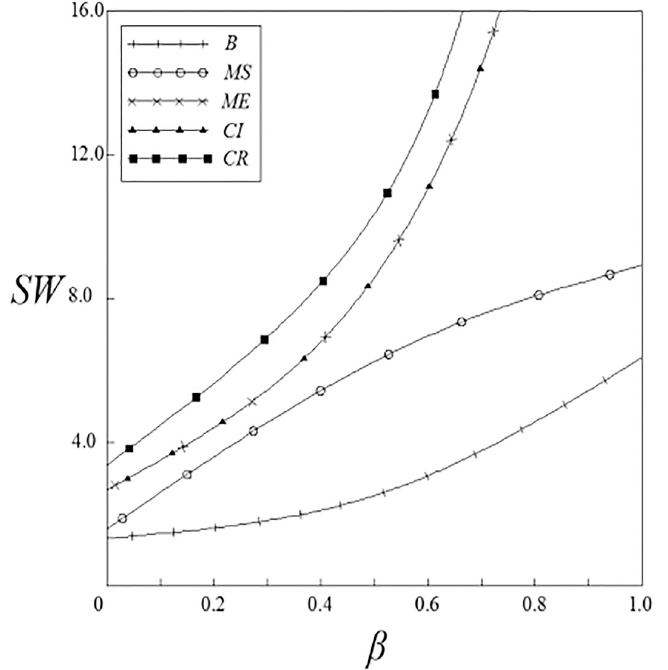
Fig 16. The relationship between SW and β